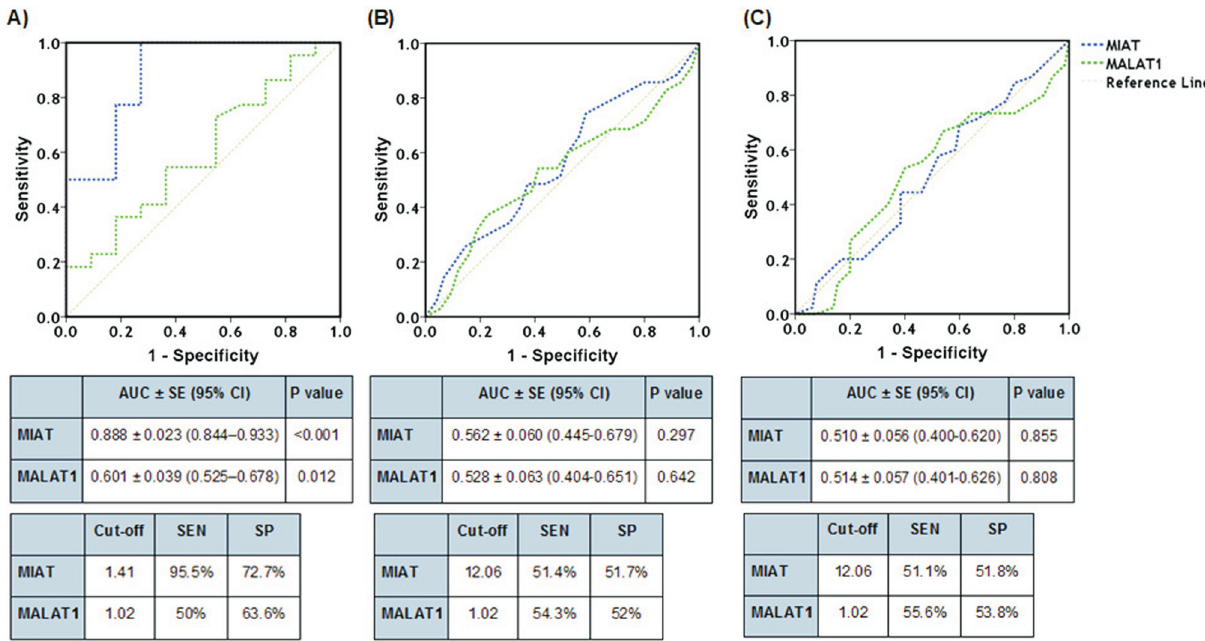
Figure 3 - Receivers operating characteristic curves of lncRNAs MIAT and MALAT1 using relative expression levels. Peripheral blood MIAT (blue line) and MALAT1 (green line) expressions were plotted to determine their sensitivity and specificity at the cutoff fold change value for detecting the presence ofsignificantcoronaryarterydisease(A),multivesseldisease(B),andhighGensiniscore>20(C)inCADpatients.AUC:Areaunderthecurve;CI:Con- fidence interval; SE: Standard error; SEN: sensitivity; SP: